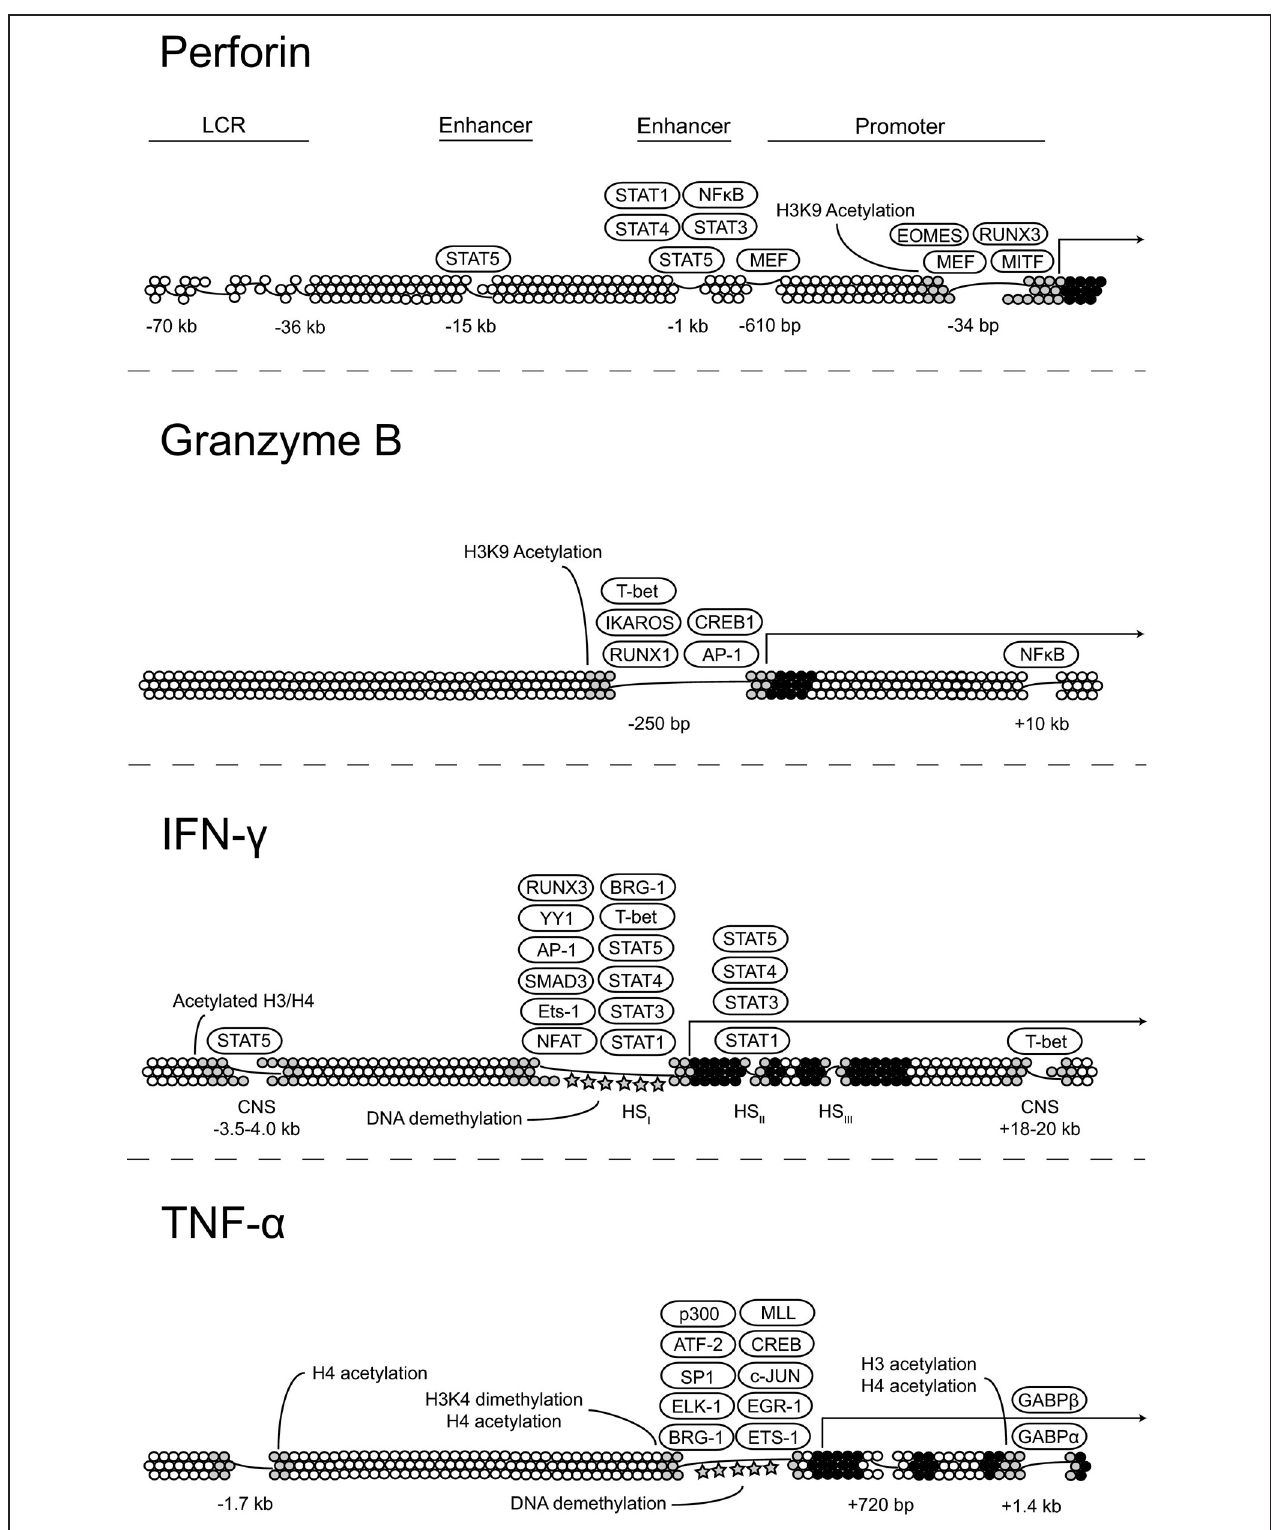
FIGURE 2 | Transcriptional and epigenetic regulation of key effector molecules. Proposed models for the regulation of perforin, granzyme B, IFN- γ , and TNF- α expression at the transcriptional level through transcription factor binding and changes in the chromatin state.